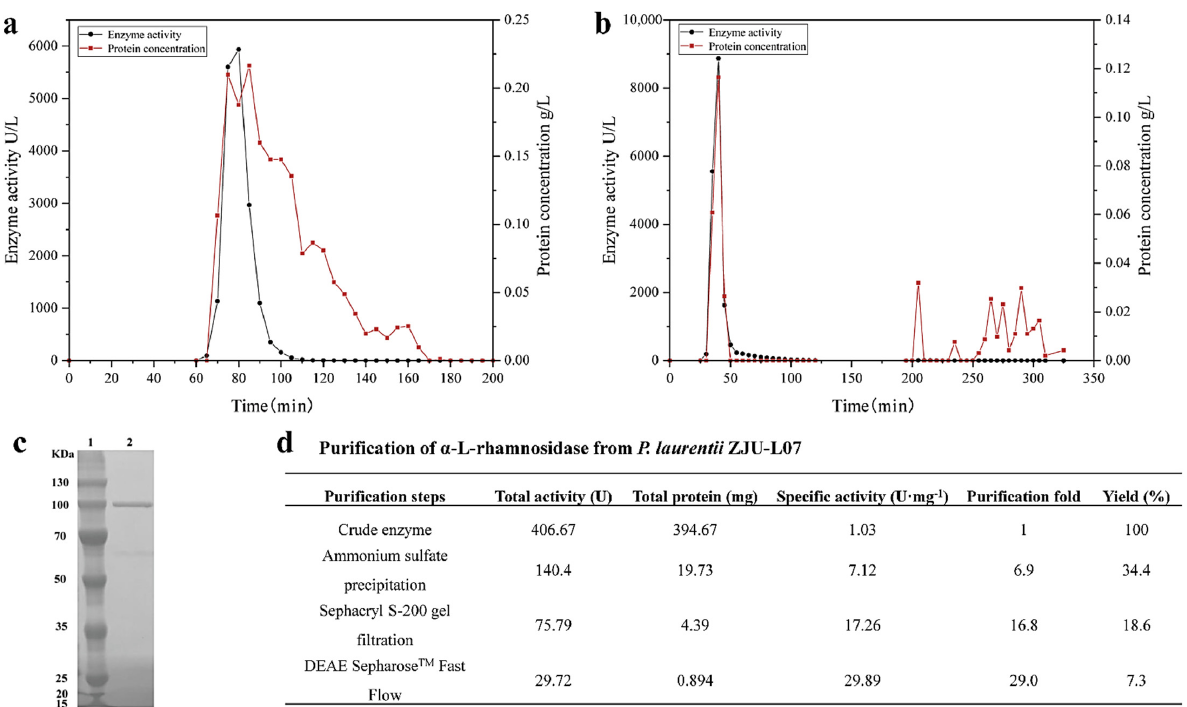
Figure 2. ( a ) Sephacryl S-200 gel chromatography of α -L-rhamnosidase. ( b ) DEAE